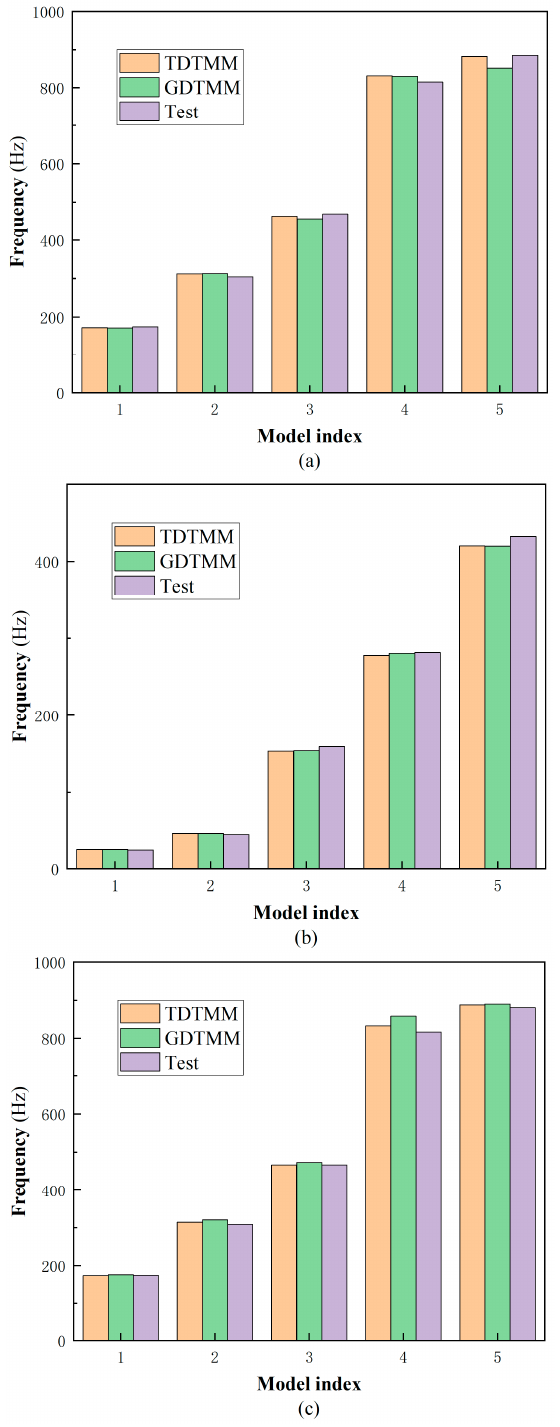
Figure 10. Dynamic response with various boundary conditions for TDTMM, GDTMM and Test: ( a ) C-C; ( b ) C-F; ( c ) F-F. Table 9. Natural frequencies (Hz) of the beams of the experimental models for three boundary con- ditions (C-C, C-F, F-F) obtained by TDTMM, GDTMM and Test. C-C Frequency Order